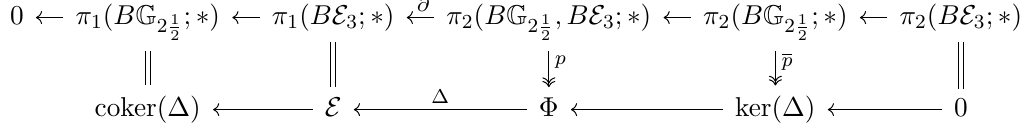
Figure 27 . Commutative diagram whose upper row is a portion of the long exact sequence of homotopy groups of the pair ( B G